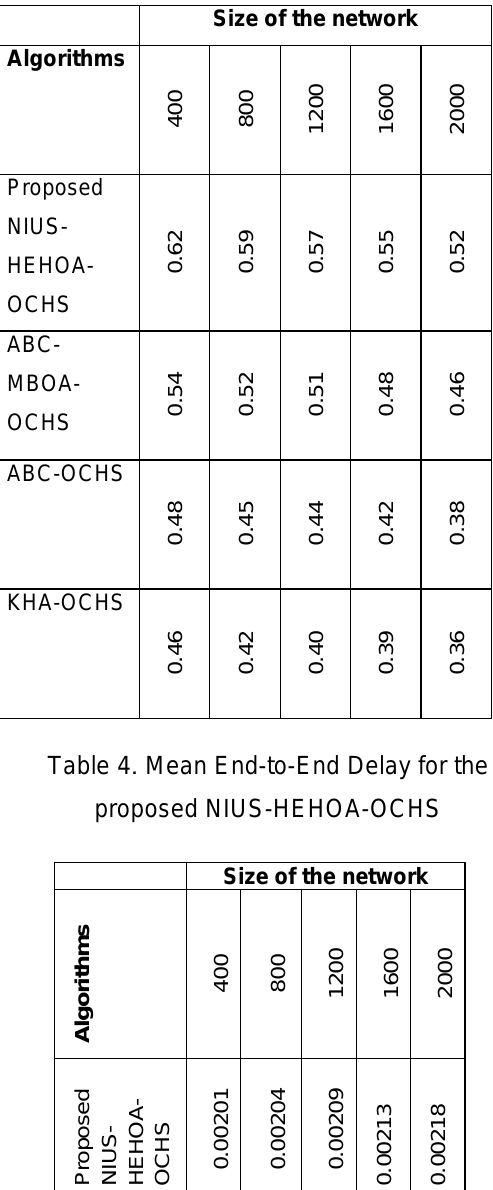
Table 3 . Mean Residual Energy for proposed